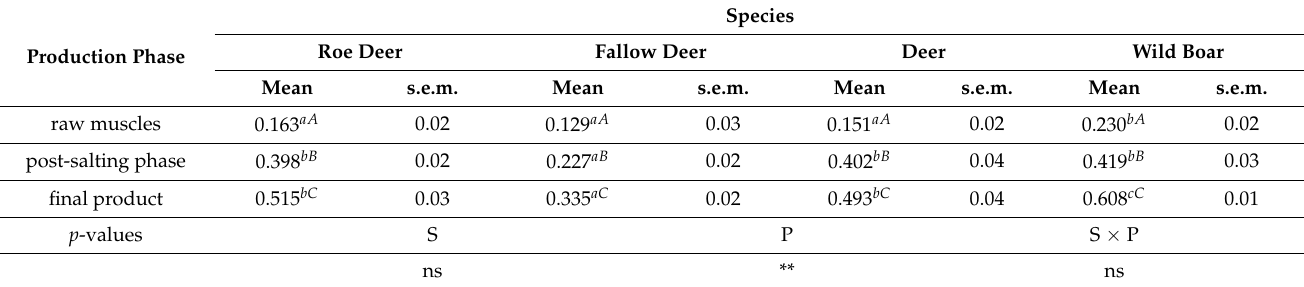
Table 3. Mean values of 2-Thiobarbituric acid-reactive substances—TBARS (mg MDA/kg) of raw and dry-cured SM ( semimembranosus ) venison